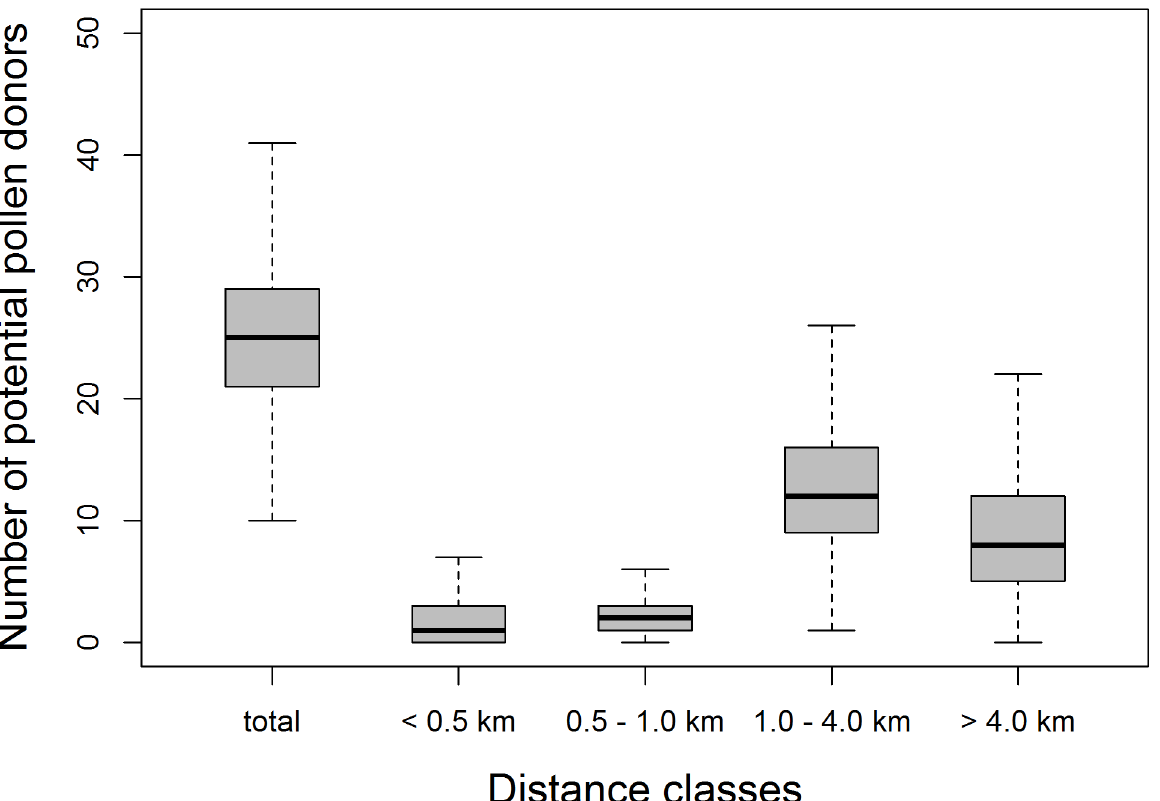
Fig 3. Simulation results of the pollen dispersal model. Results are based on simulations with a receptive and release phase of six days. Boxplots represent the number of trees that can act as potential pollen for each receptive F . inspida tree at the given distance classes. Results are based on 10 runs.